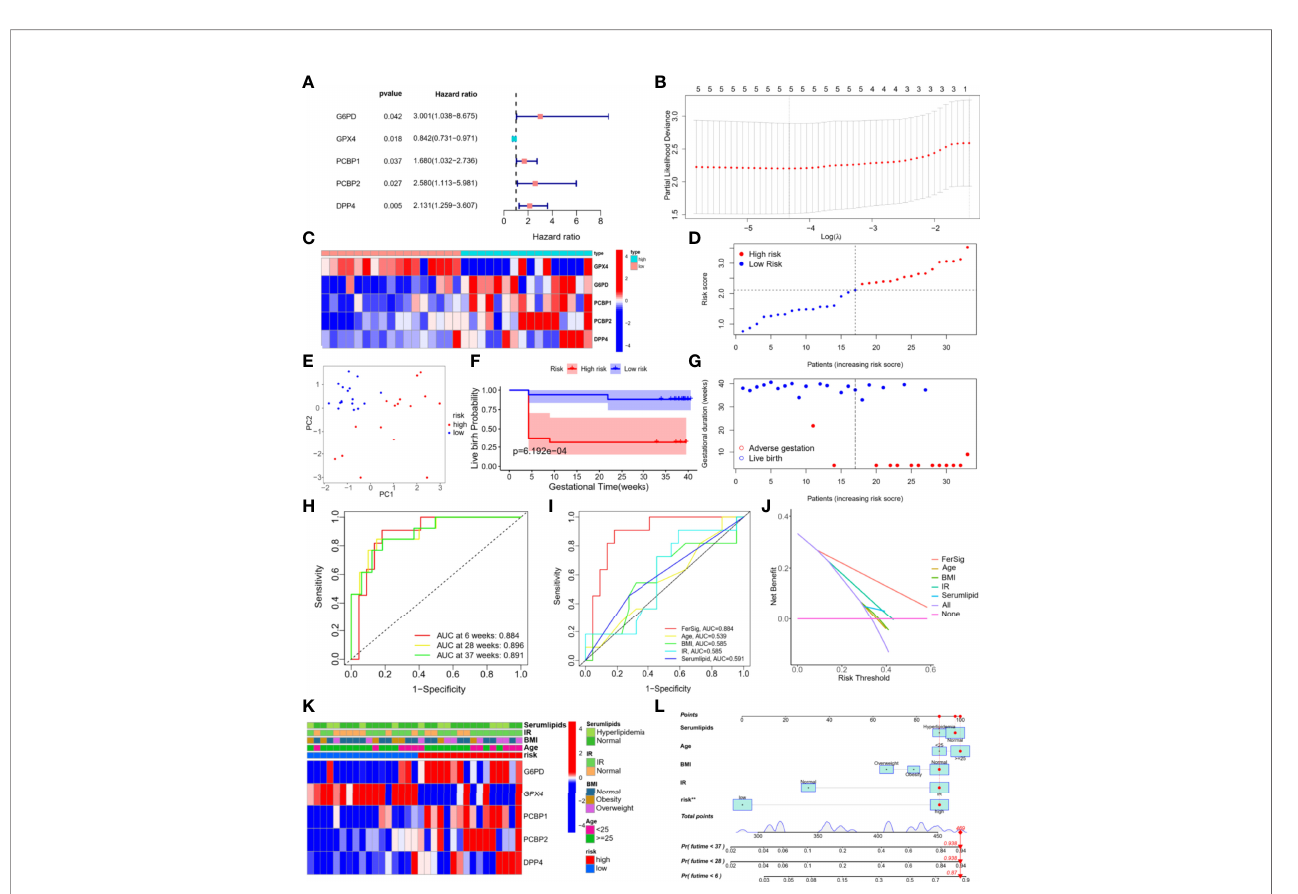
FIGURE 4 | Establishment and evaluation of the FerSig risk prognostic